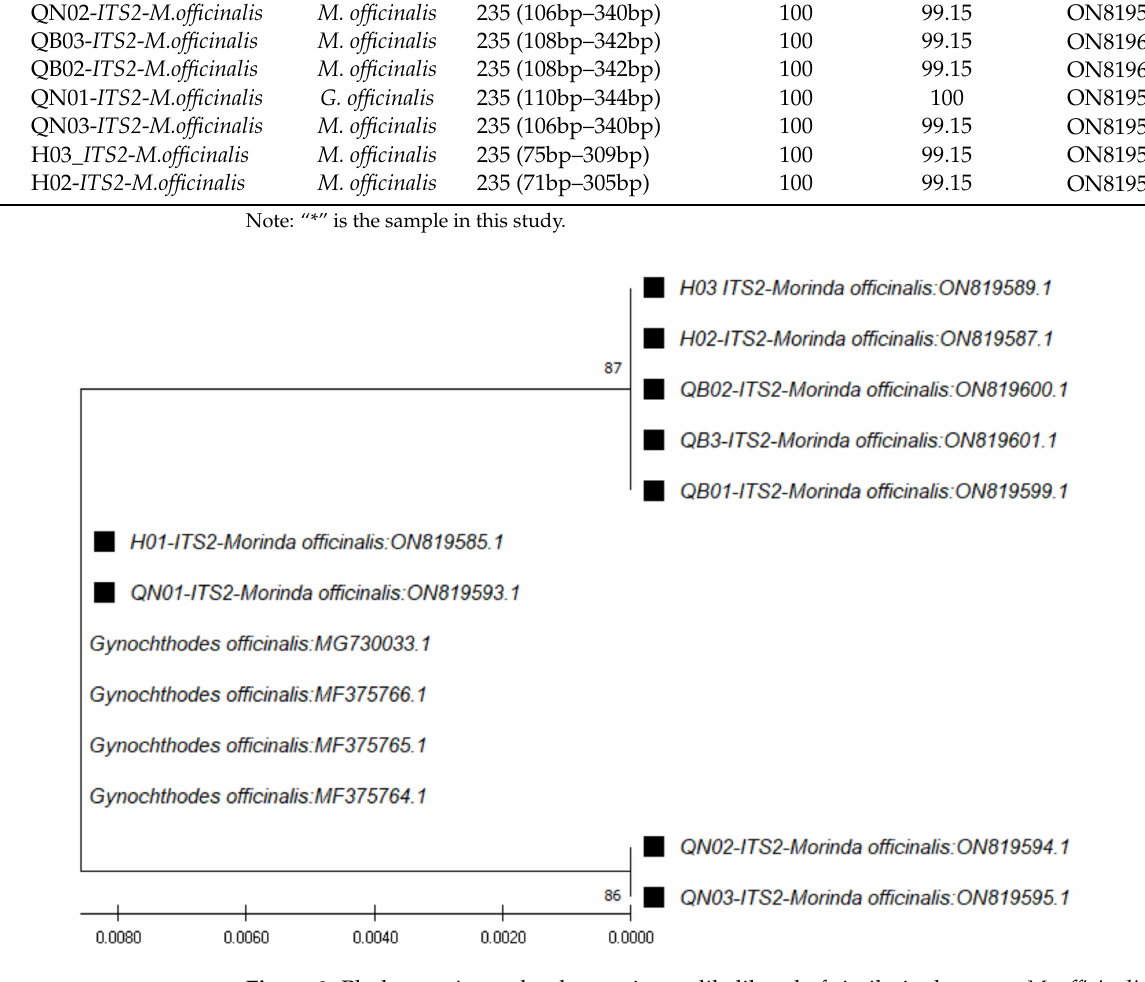
Figure 3. Phylogenetic tree by the maximum likelihood of similarity between M. officinalis and the closest species as per ITS2 region sequences. The samples of our study are marked by black squares next to their